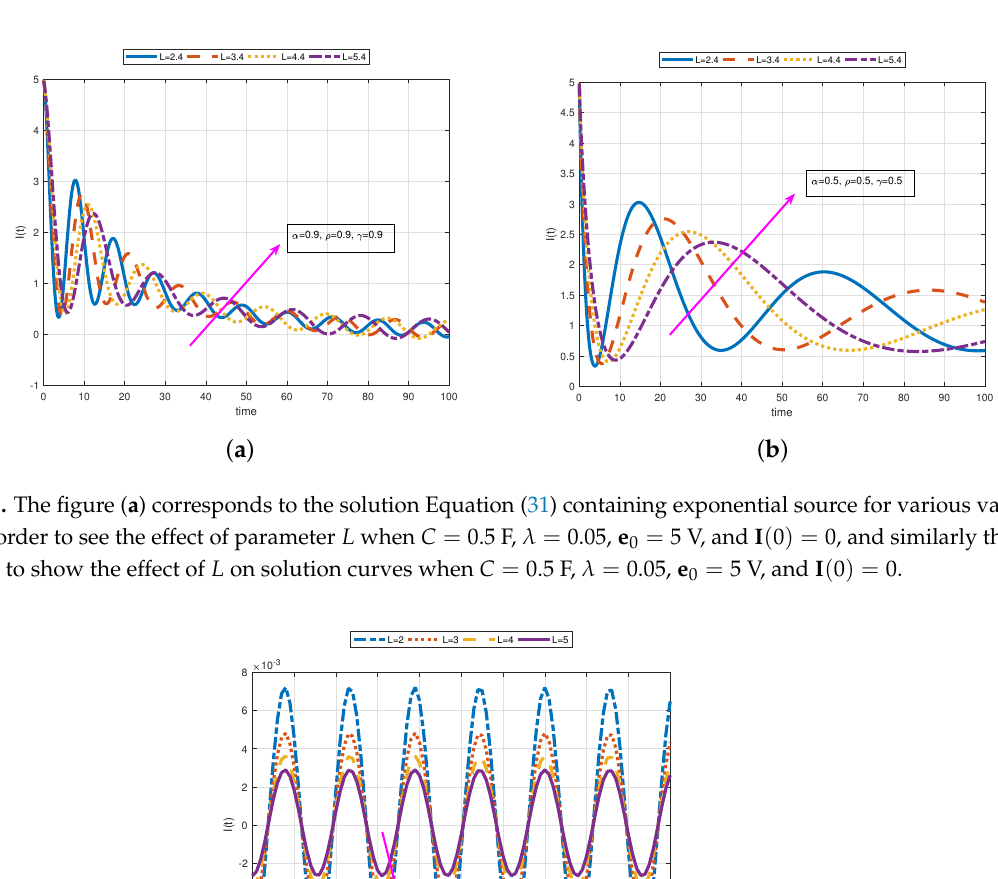
Figure 10. This graph corresponds to the solution Equation (31) containing exponential source for various values of α and ρ when γ = 0.9, C = 0.5 F, L = 2.4 H, λ = 0.05, e 0 = 5 V, and I ( 0 ) = 0.